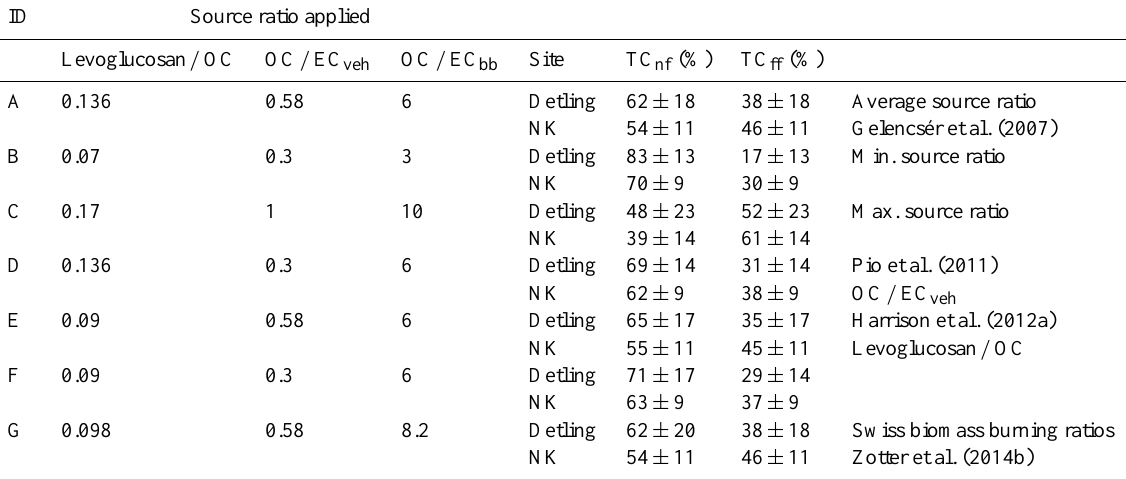
Table 4. Average of daily percentage fraction of non-fossil and fossil TC using different source ratios. OC / EC veh and OC / EC bb refer to the source ratio of primary vehicle and biomass burning emissions respectively. Variability shown is 1 standard